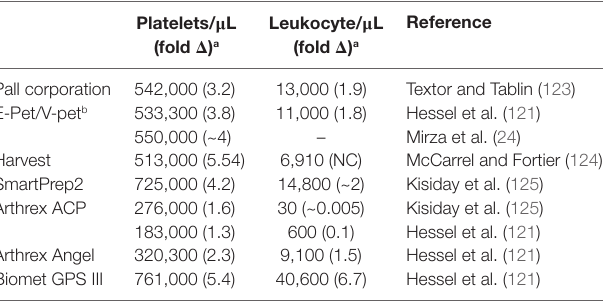
TABLe 3 | Average platelet and leukocyte counts reported for commercially available platelet-rich plasma systems in the